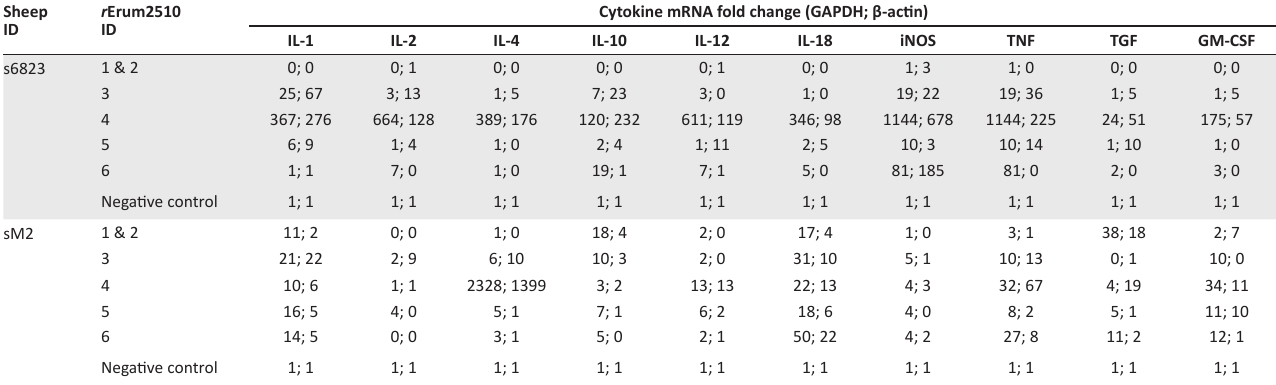
TABLE 1: Relative fold change in cytokine mRNA isolated from sM2 and s6823, stimulated with Erum2510 r proteins and normalised to endogenous reference genes glyceraldehyde 3-phosphate dehydrogenase (GAPDH) and β -actin, relative to an untreated negative control (unstimulated peripheral blood mononuclear cell). Sheep r Erum2510 ID ID